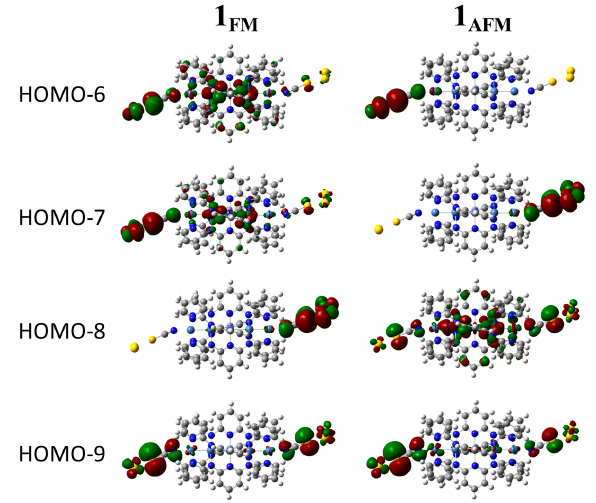
Figure 5. From α -HOMO-6 to α -HOMO-9 of 1 FM and 1 AFM .